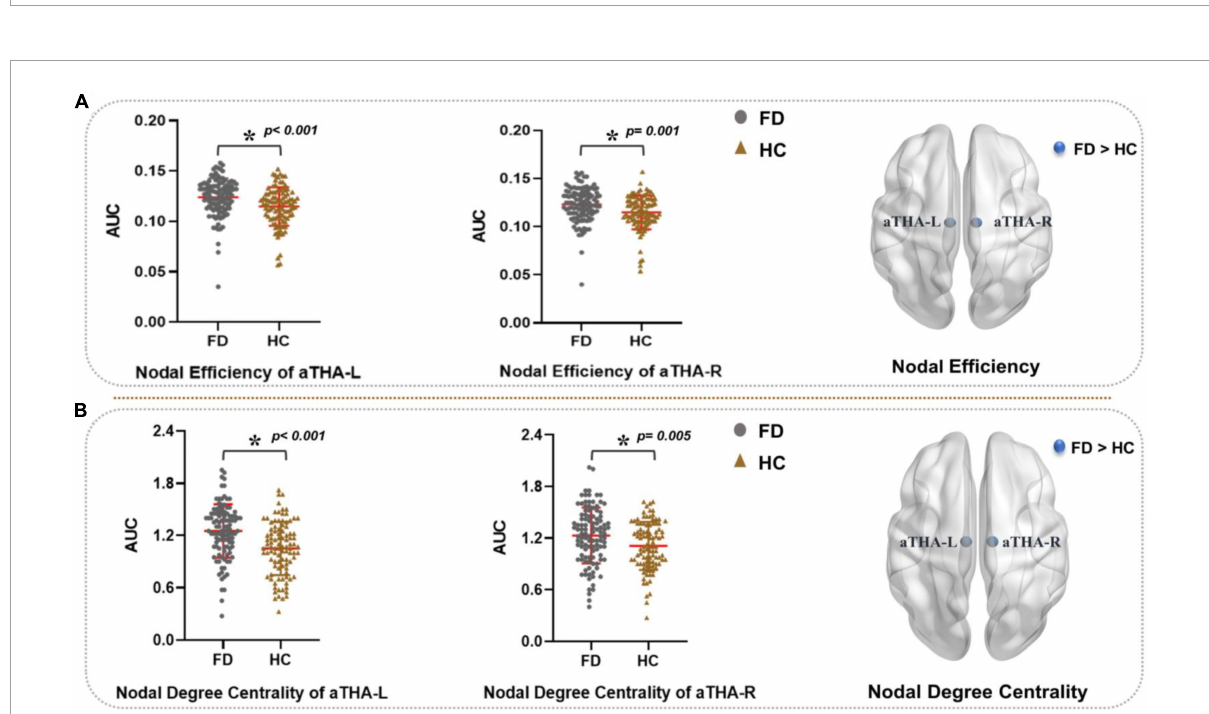
FIGURE3 Alterations in the AUC of nodal properties in FD patients ( p FDR < 0.05). FD patients showed: (A) higher nodal efficiency and (B) nodal degree centrality in aTHA. Abbreviations: L, left; R, right; AUC, area under the curve; FDR, false discovery rate; FD, functional dyspepsia; HC, healthy controls; aTHA-rh, anterior right head of thalamus; aTHA-lh, anterior left head of